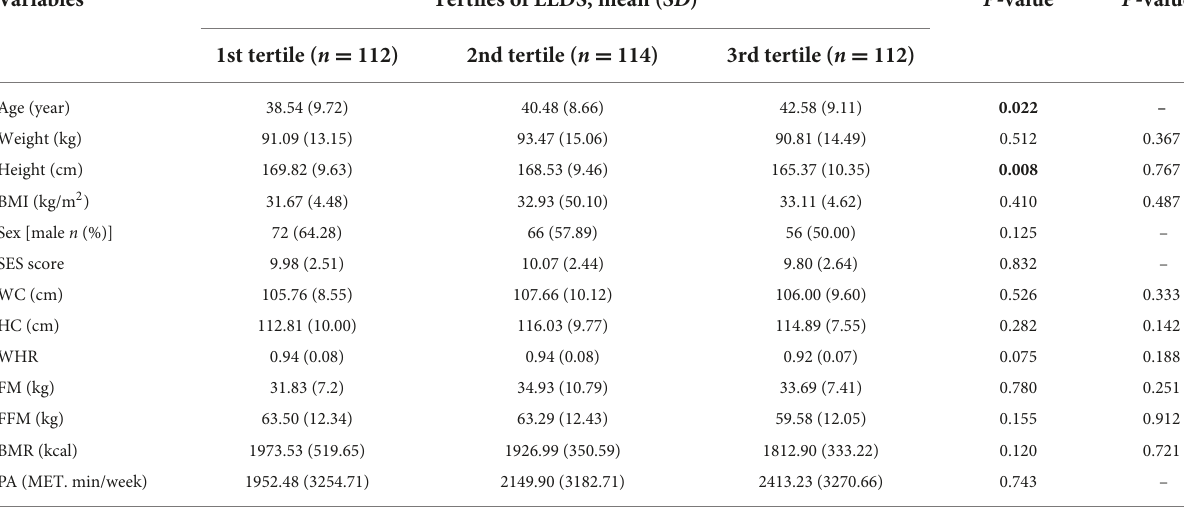
TABLE 1 Demographic and anthropometric characteristics of participants across different tertiles of LLDS. Variables